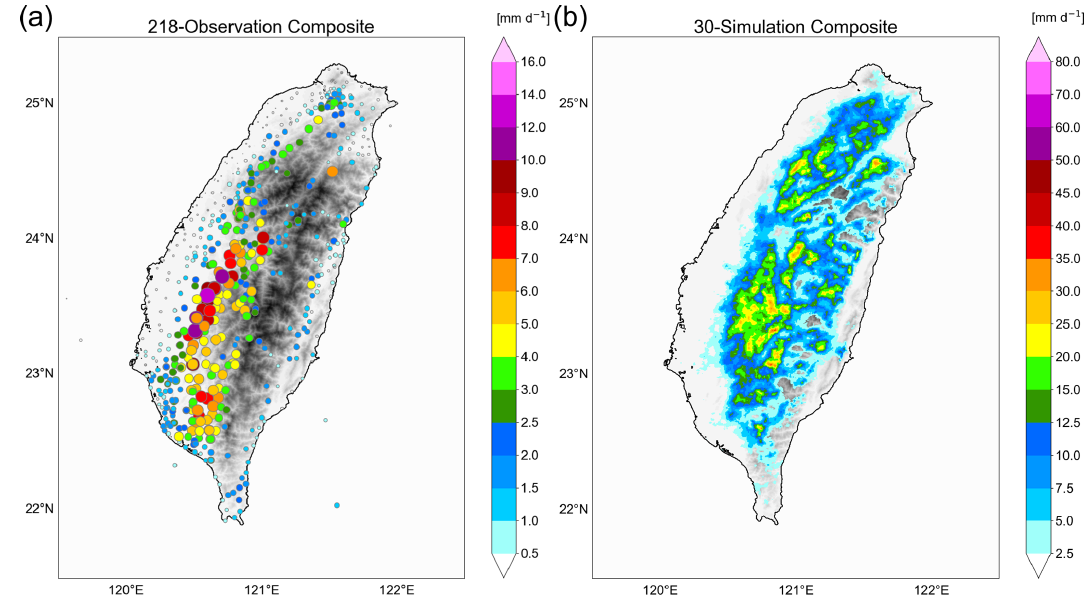
Figure 4. The composite daily mean precipitation of (a) all 218 weak synoptic days from Central Weather Bureau rain gauge observations (the sizes of colored dots are scaled with the mean precipitation) and (b) all 30 semi-realistic simulations under the clean scenario on the island of Taiwan. Grey shading shows the orographic heights (same as in Fig. 1).